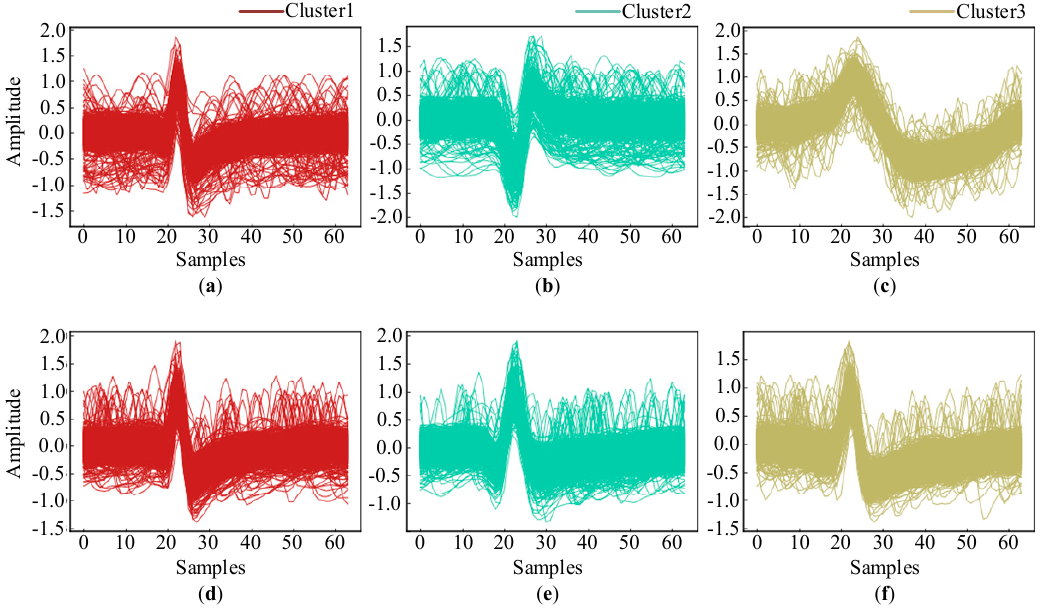
Figure 6. Waveforms of spikes in each cluster: ( a – c ) C_Easy1_noise015; ( d – f ) C_Difficult1_noise015.